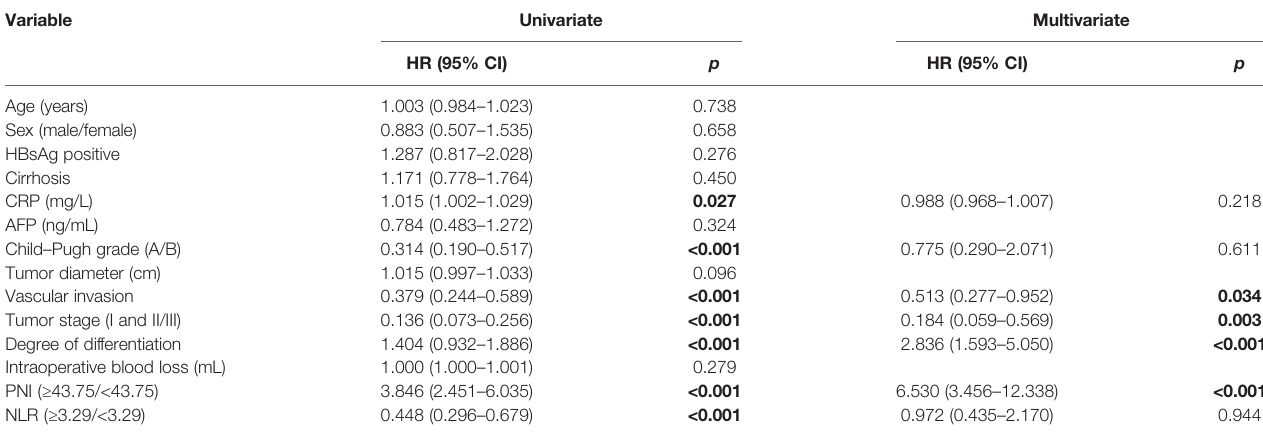
TABLE 4 | Univariate and multivariate analyses of prognostic factors for recurrence-free survival of patients. Variable